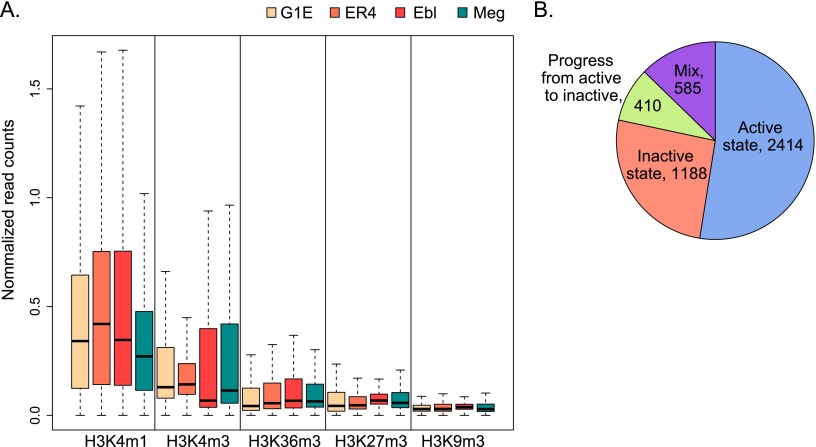
Histone modifications and chromatin states on TAL1 OSs. (A) Levels of five histone modification ChIP-seq signals (shown by box plots) in G1E, G1E-ER4 + E2, Ter119+ erythroblasts, and megakaryocytes were computed on the DNA segments occupied by TAL1 OSs in each cell type. (B) Chromatin states were determined using chromHMM (Ernst and Kellis 2010; Ernst et al. 2011) after learning the model from the five histone modifications in multiple cell types (Cheng et al. 2014). The pie chart shows the number of HPC-7-only TAL1 OSs that carry the designated pattern of chromatin states in the three erythroid cell types.